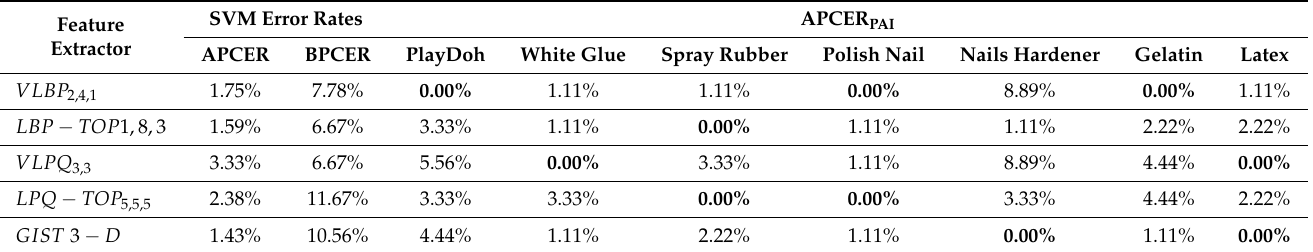
Table 8. Attacks strength considering different PAI species (optical sensors).